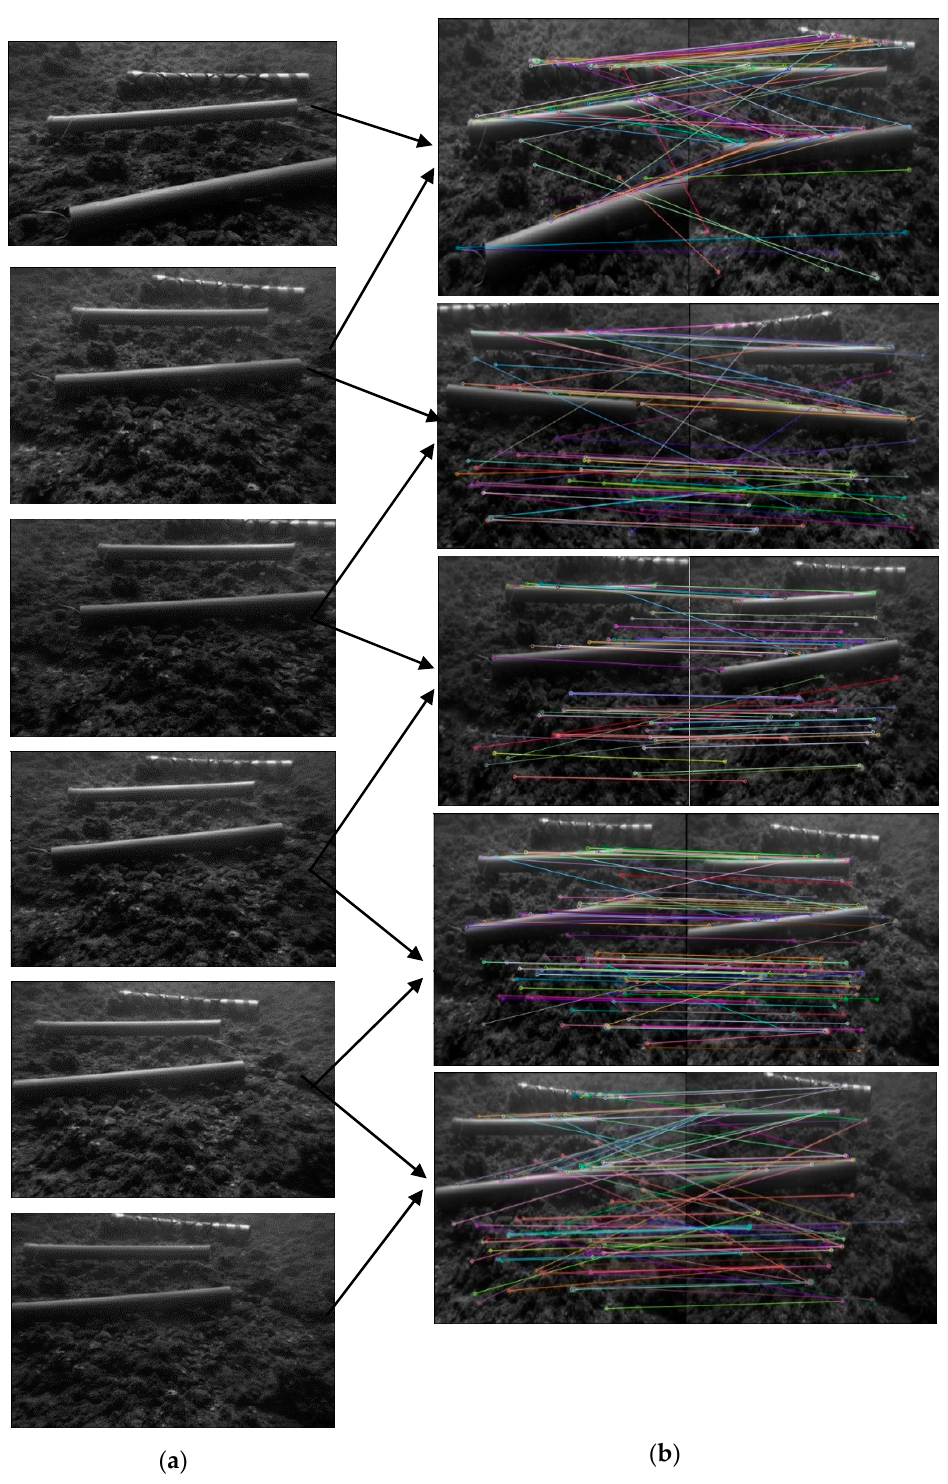
Figure 5. Image matching for ( a ) two original images (in each step) and ( b ) The result of image matching using (2D) 2 PCA and A-KAZE algorithms.